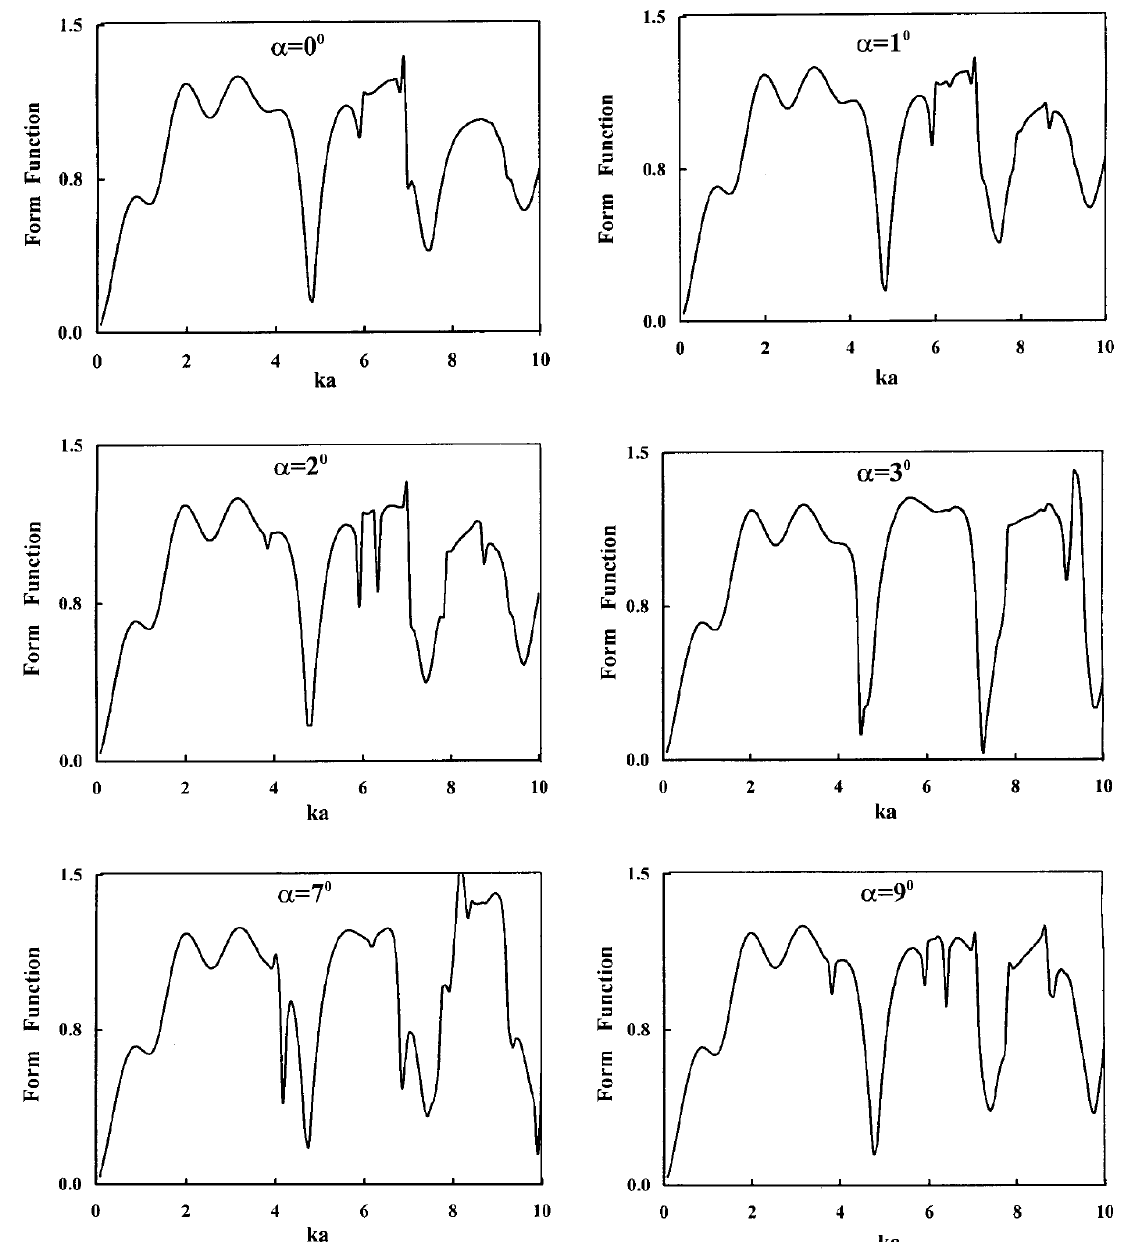
Fig. 13. Form function amplitude versus nondimensional frequency for a solid aluminium cylinder ( h/a ≈ 1 ) immersed in water for selected angles of wave